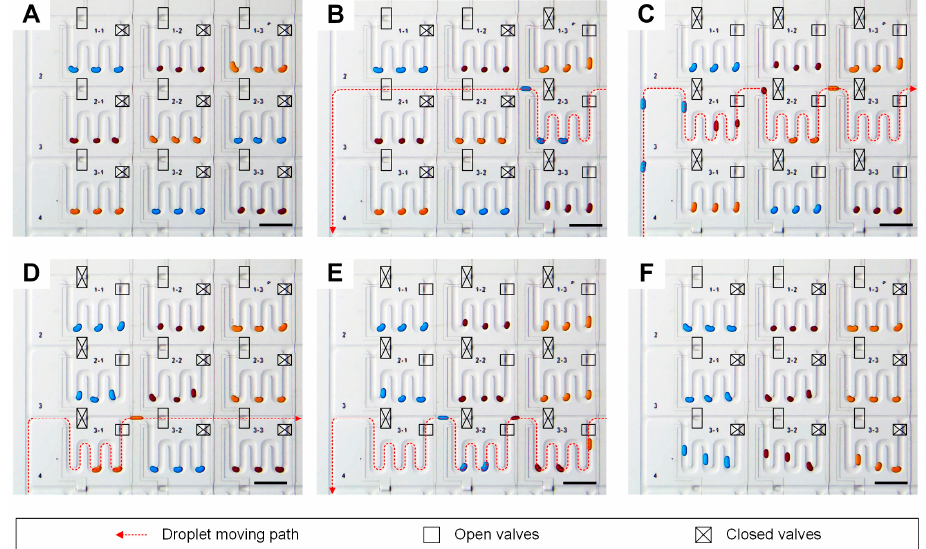
Figure 3. Droplet addressing in the storage unit array. ( A ) Nine sets of three droplets were isolated in a 3 × 3 storage unit array with random orders in droplet colors. ( B – E ) By moving the droplets with the control of carrier fluid flow direction as well as droplet moving path, ( F ) the color orders of droplets in each row rearranged to blue, red and yellow. Scale bars: 500 μ m.